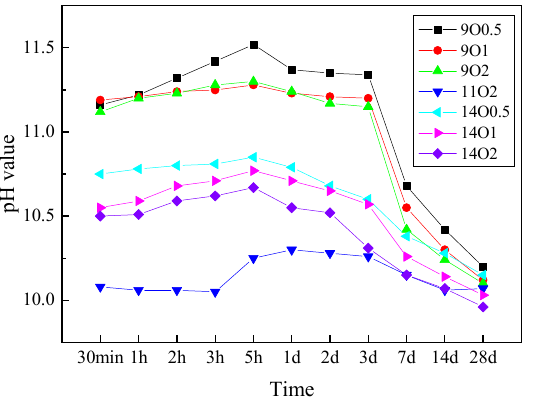
Figure 7. pH values of SF and MgO mixtures calcined at different temperatures, cooled in the